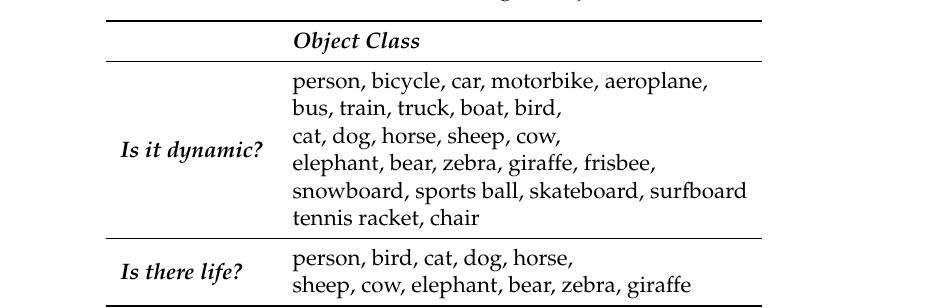
Figure 6. Overview of syntax analysis. Table 1. Inferred knowledge in